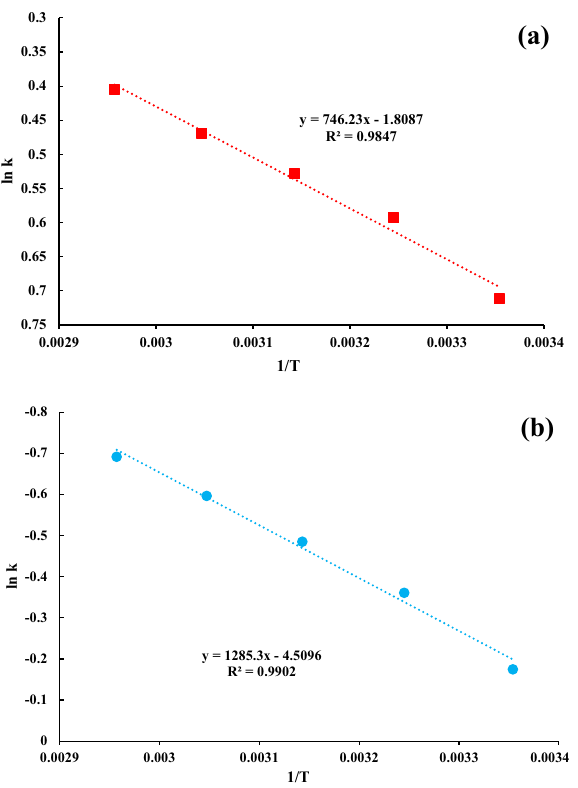
Figure 6. Vant’ Hoff plot for the phenol adsorption onto ( a ) MSAC and ( b ) pristine activated carbon.